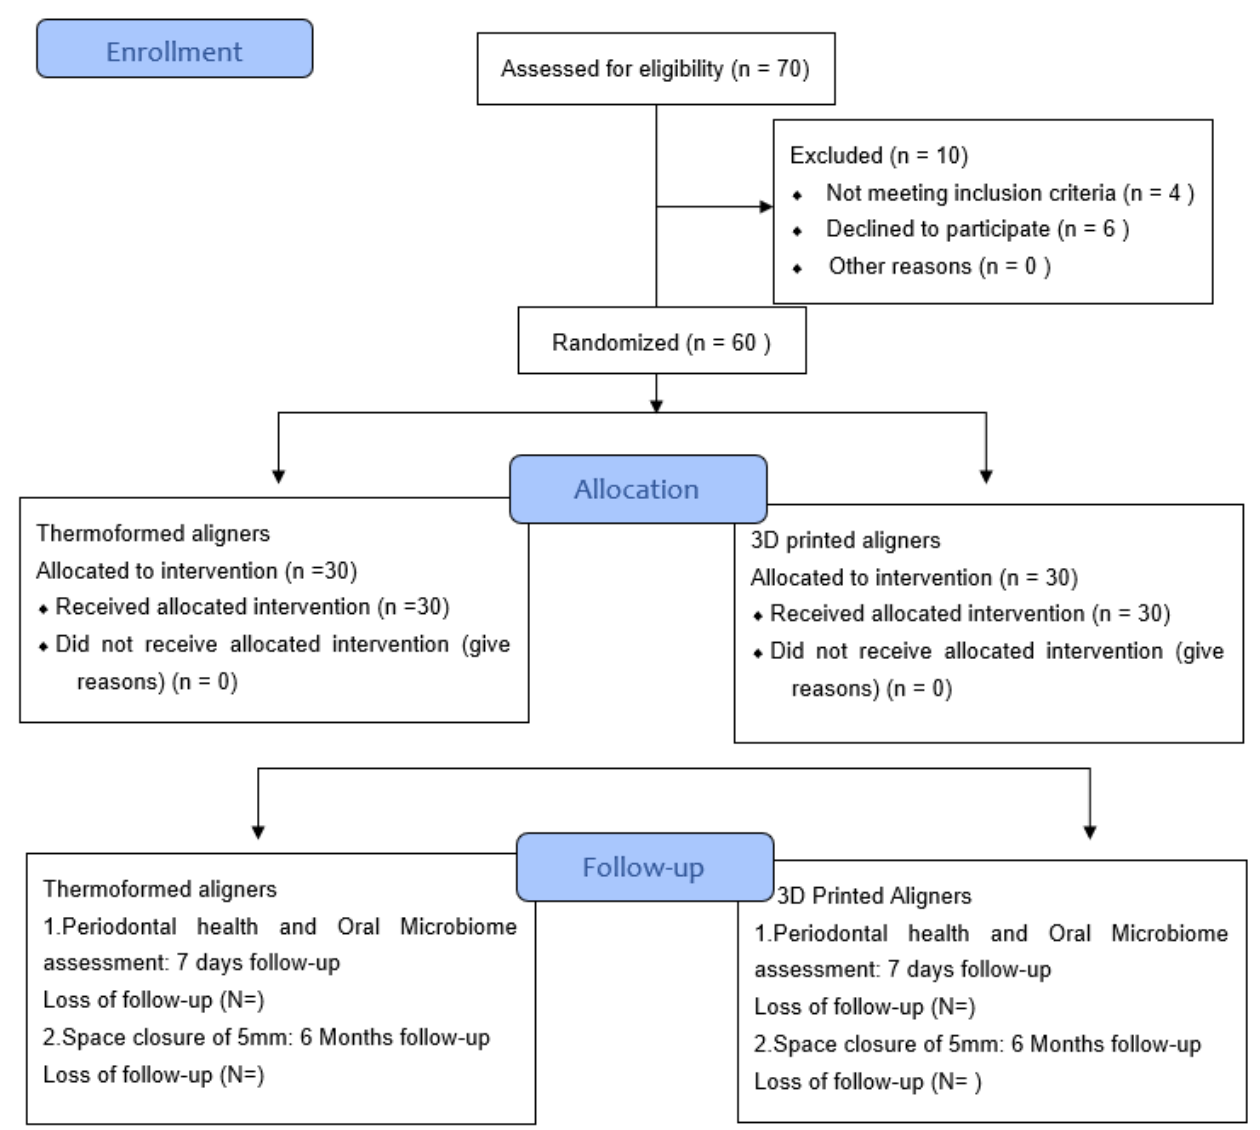
Figure 1. CONSORT 2010 Flow Diagram.